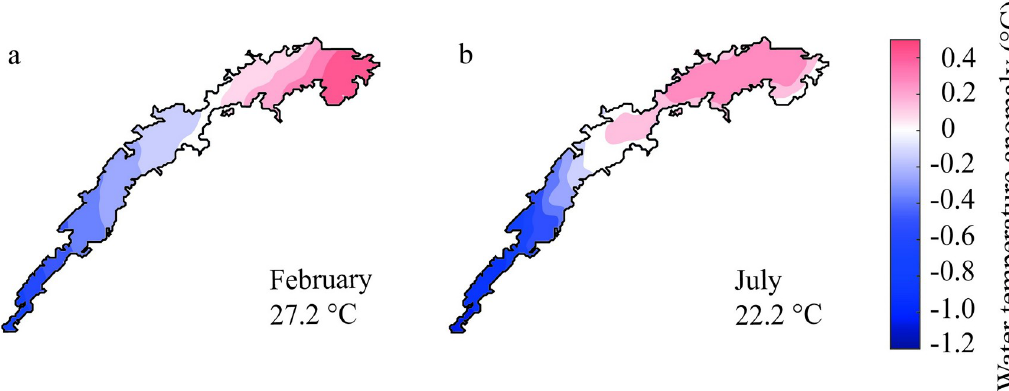
Fig 5. Anomaly maps of lake surface water temperature. Water temperature anomaly shown as spatial deviation from the satellite-derived mean monthly surface water temperature for the years 2007–2009 in (a) the warm-wet season (February) and (b) the cold-dry season